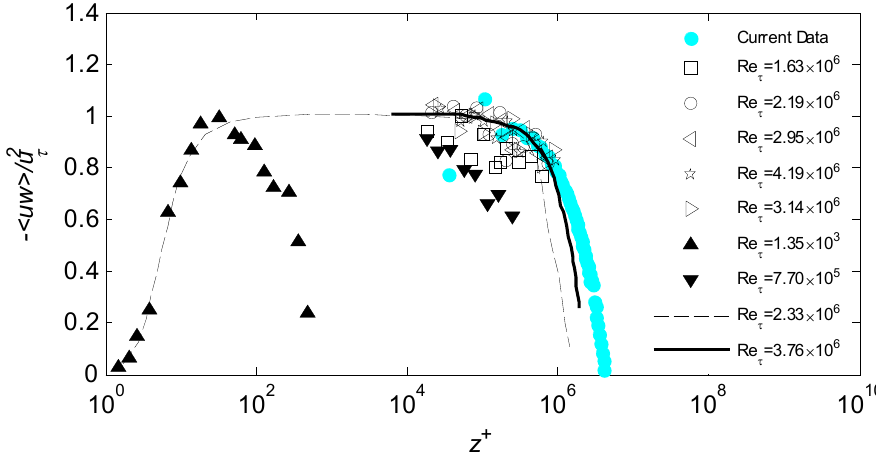
Figure 3. Comparison of Reynolds stress with inner-scaled height: The solid colored symbols are current simulation data, the dashed line is Chauhan [34] for Re τ = 2.33 × 10 6 , the solid line represents Re τ = 3.76 × 10 6 , the solid black upward-facing triangles exhibit the wind tunnel results of Graa ff and Eaton [37] at Re τ = 1.35 × 10 3 , the solid black downward-facing triangles give the results of the field observations of Hutchins et al. [36] at Re τ = 7.7 × 10 5 , the open symbols show the field-measured QLOA data of Wang and Zheng [9], the black open squares represent Re τ = 1.63 × 10 6 , the black open circles give Re τ = 2.19 × 10 6 , black open leftward-facing triangles present Re τ = 2.95 × 10 6 , the black open rightward-facing triangles present Re τ = 3.14 × 10 6 , and the black open stars are Re τ = 4.19 × 10 6 .